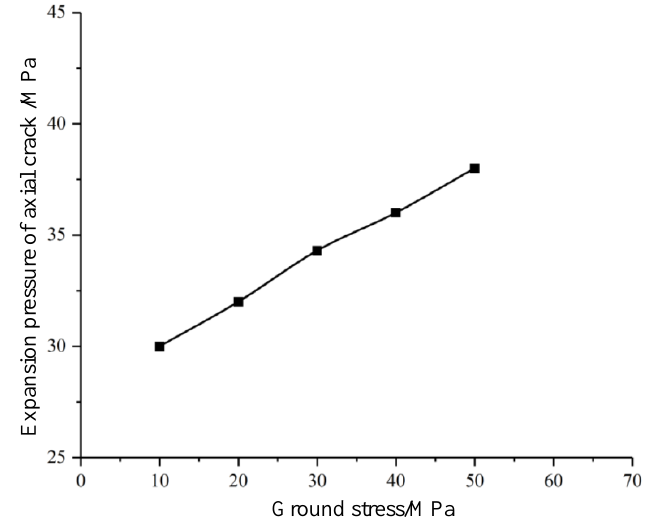
Figure 16. The effect of ground stress on the pressure of crack opening after 200 s of injection. (3) The e ff ect of mechanical parameters of cement sheath on the crack propagation